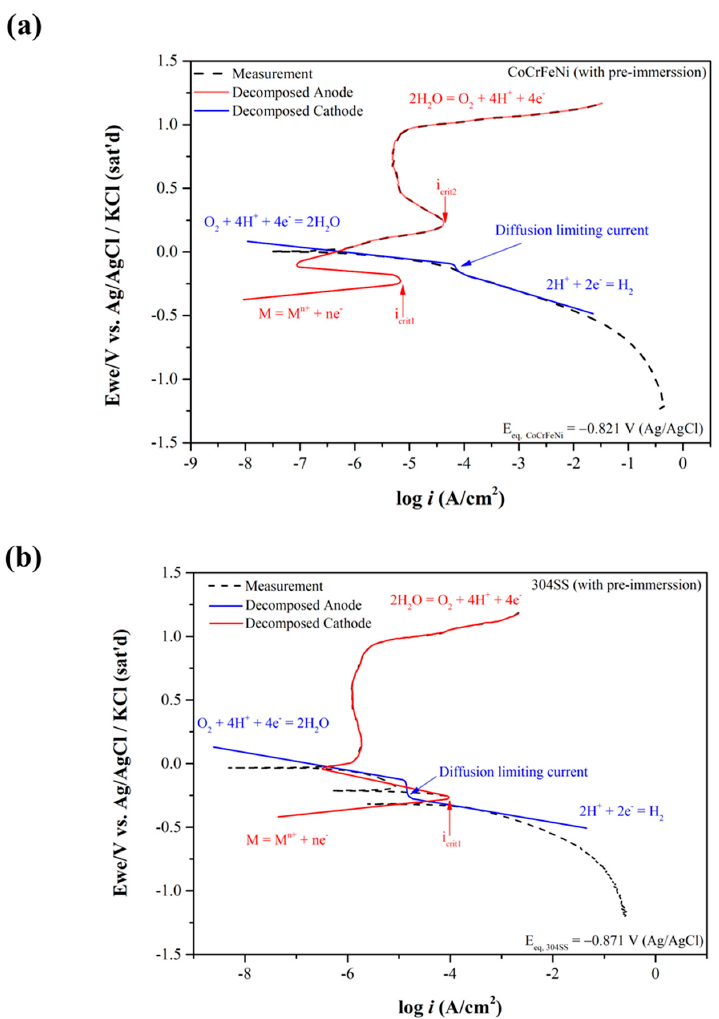
Figure 3. Dynamic polarization curves of ( a ) CoCrFeNi HEA and ( b ) 304SS with pre-immersion for 30 min, also decomposed into the anodic and cathodic ones.